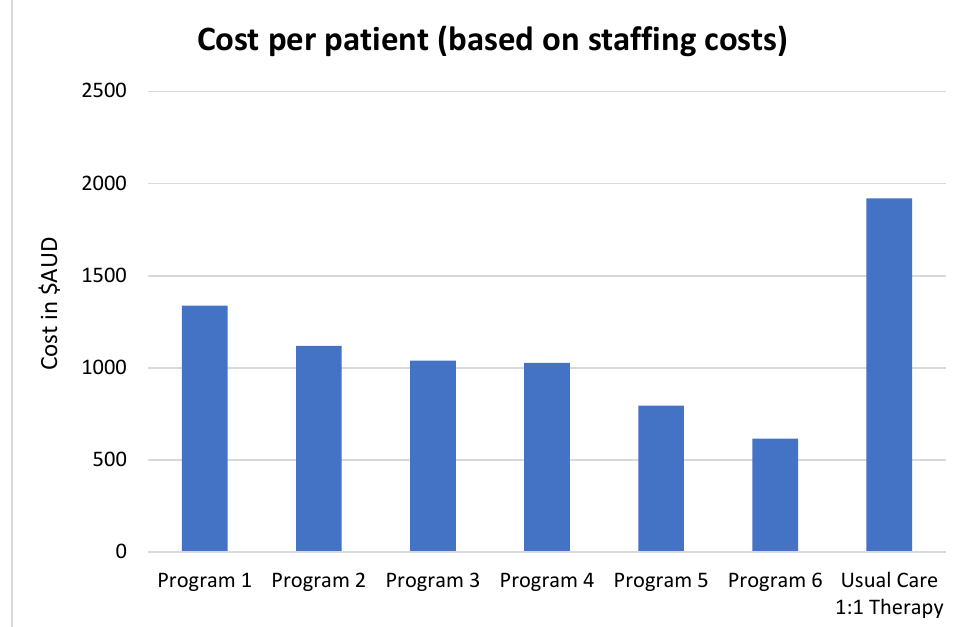
Figure 5. Staff cost per patient.